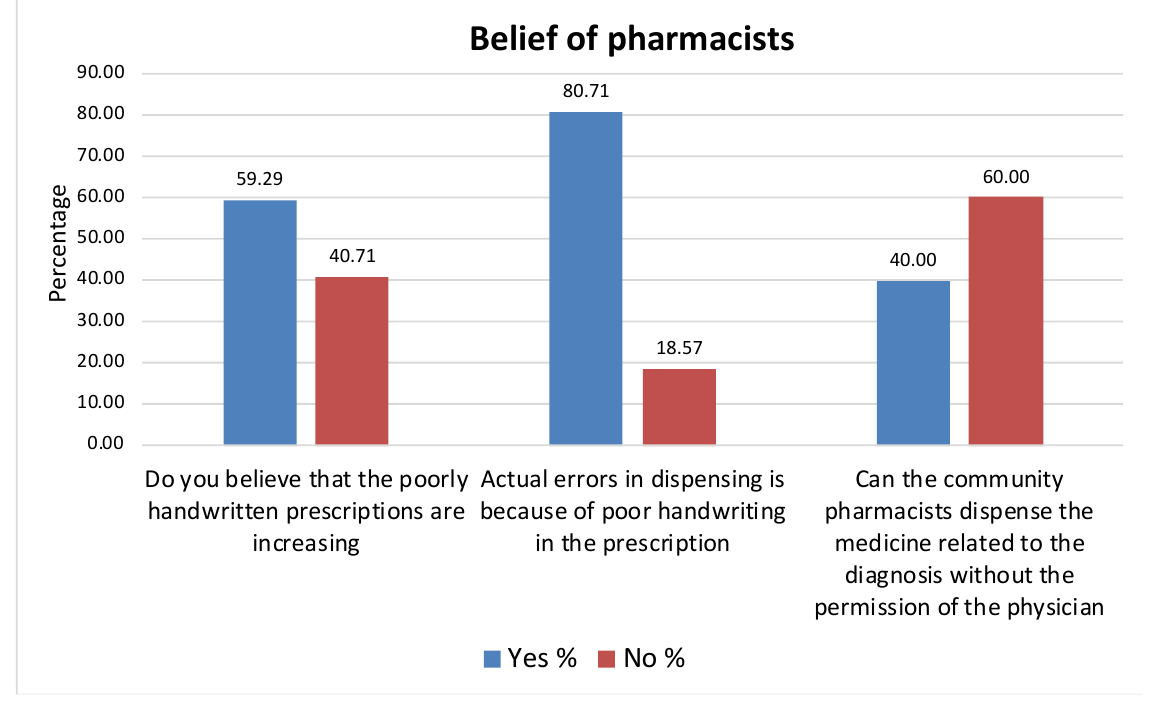
Figure 1. Beliefs of pharmacists of poorly handwritten prescriptions.